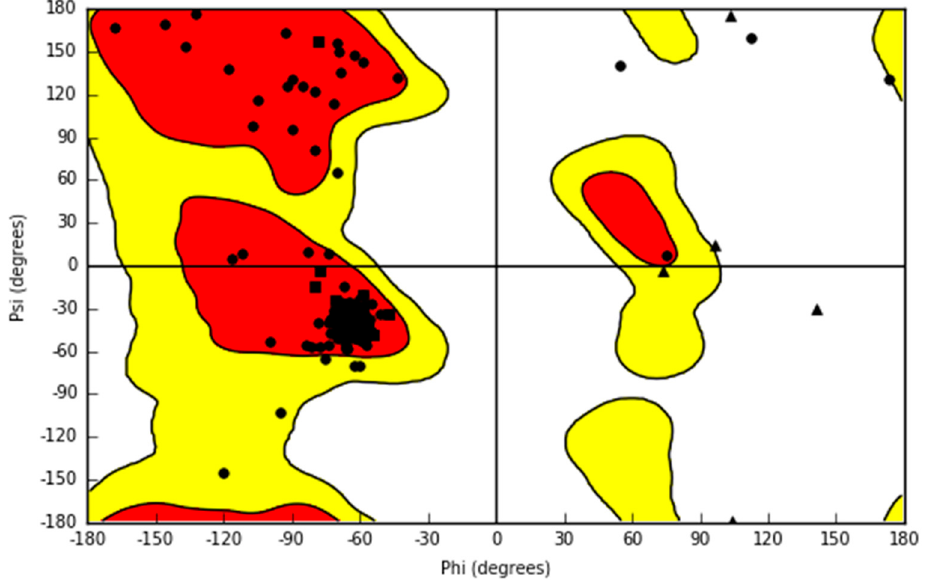
Figure 3. The Ramachandran plot of the final homology model of serotonin 5-HT 7 receptor. Most residues are represented by circles. Glycines are shown as triangles. Prolines are shown as squares. Two outliers are Asn 226 and Ile 353, which are in extracellular loop regions.